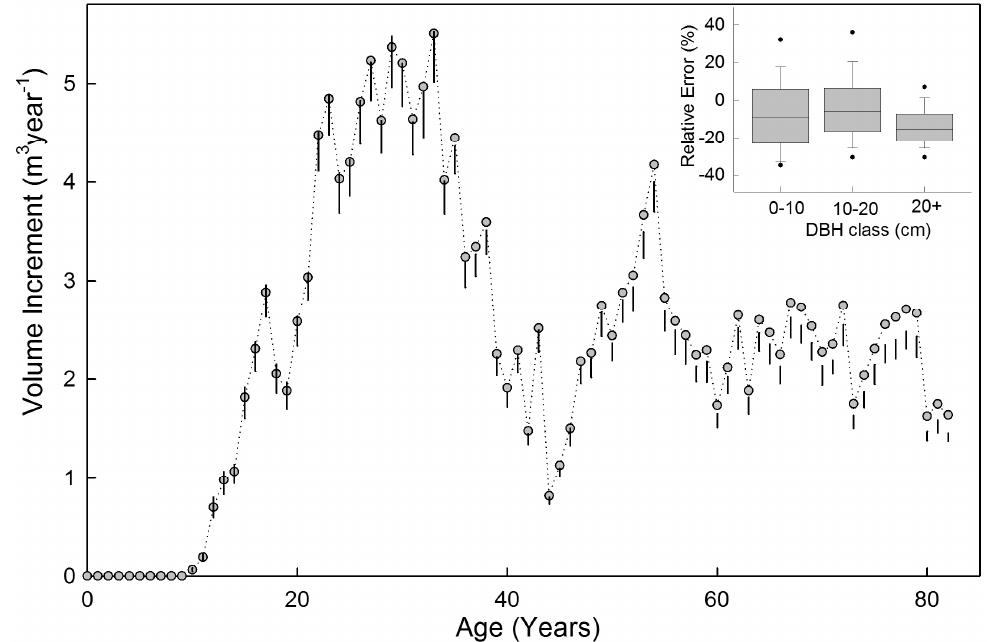
Figure 2. Time series of above ground volume increment (m 3 · ha − 1 · year − 1 ) with stand age for a 900 m 2 fixed area jack pine plot in Saskatchewan, Canada, for which all live and dead trees present in the stand at age 82 were sampled at breast height for ring width measurement. The line plot represents volume increment derived from these measurements using a regional volume model using corrected height as input. Error bars represent the 2.5th and 97.5th percentiles of stand level estimates of volume increment, derived from diameter class ‐ based relative errors (inset graph) derived from the observed difference in breast height and whole tree ‐ derived growth increment for this species and volume estimation method.